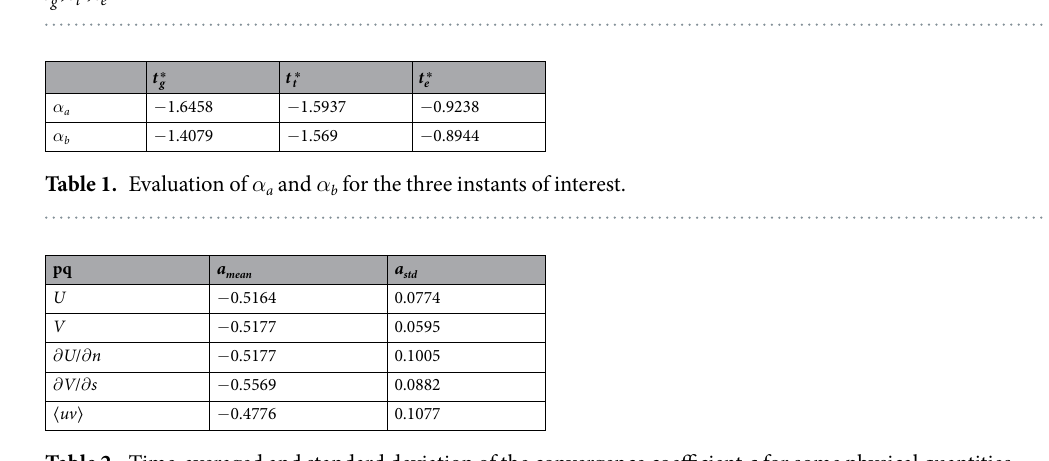
Figure 5. Behavior of e 1 and e 2 with reference to the mean simple shear along the breaker. From top to bottom: ⁎ t , ⁎ t , ⁎ t . t e g